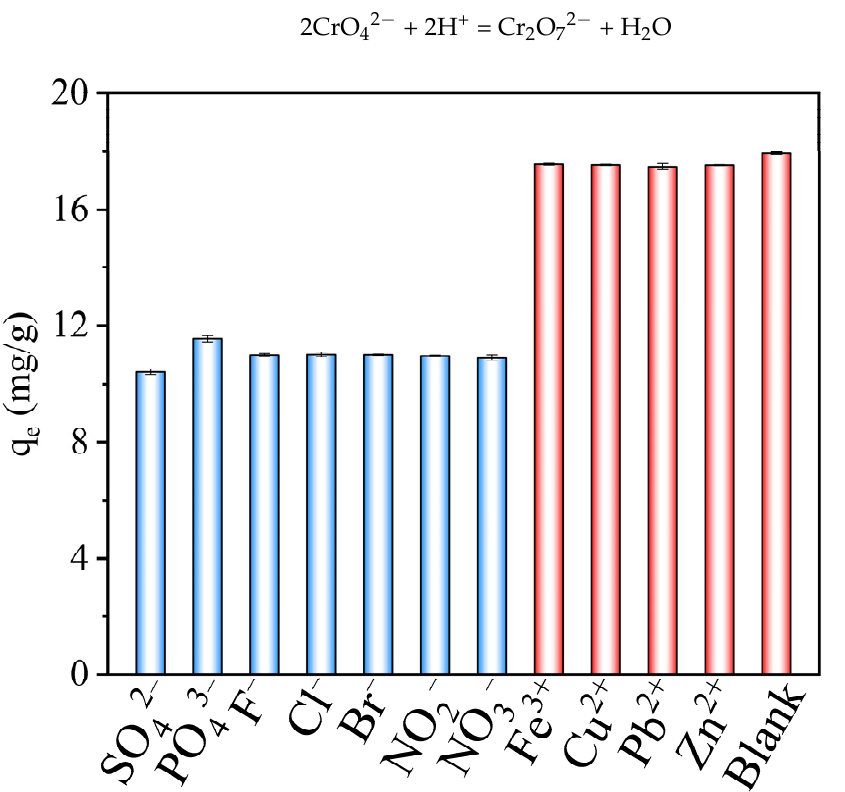
Figure 10. Adsorption of Cr(VI) by MCM-48-SH under different coexisting ionic conditions (the reaction temperature was 25 °C, the amount of adsorbent was 25 mg, the pH of the solution was 2, and the reaction time was 3 d).